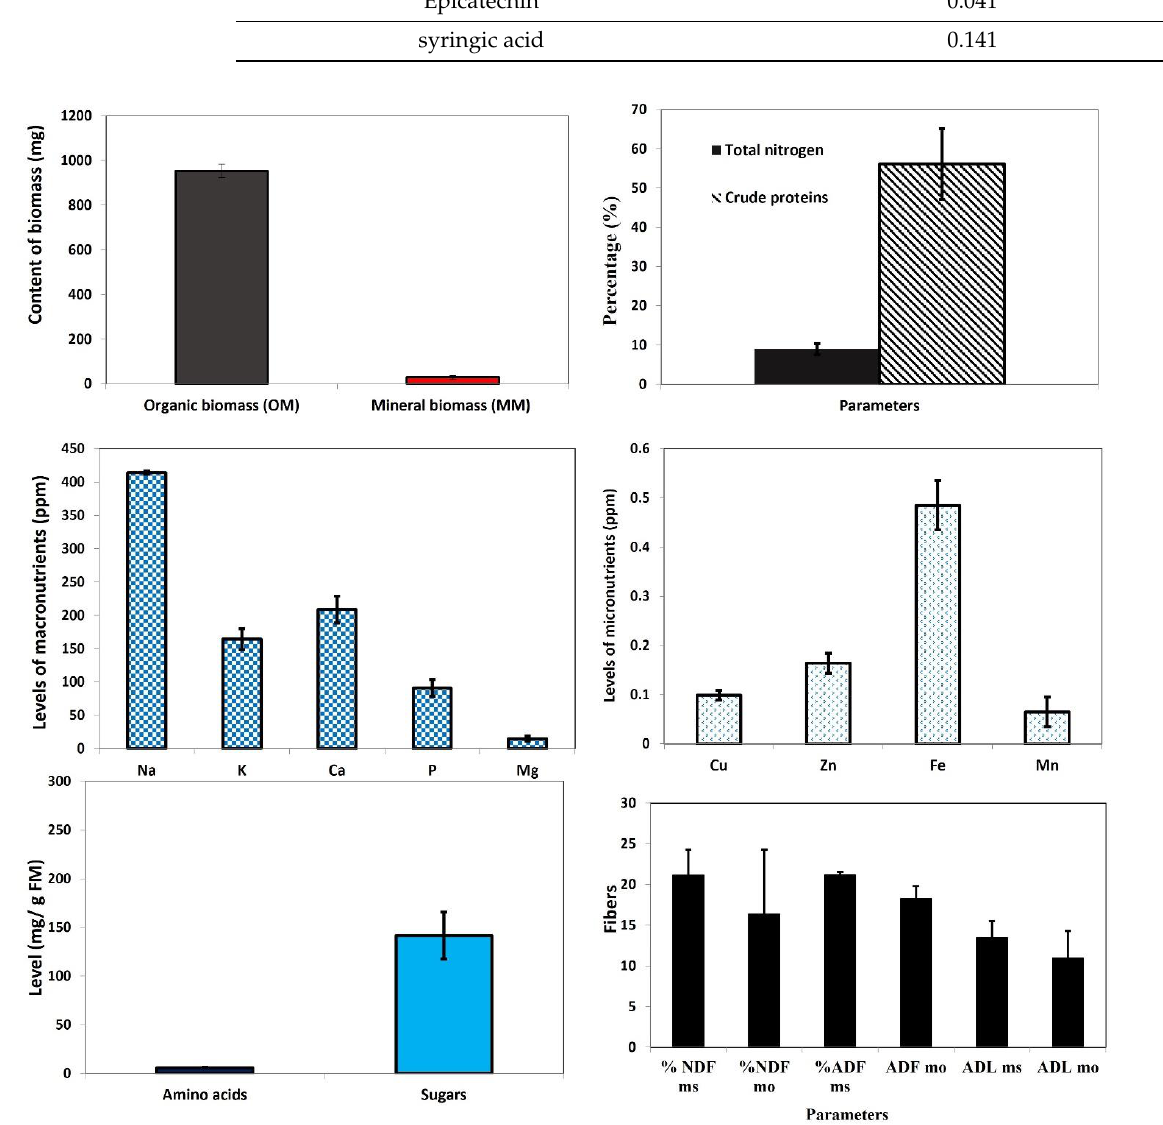
Figure 5. Contents (levels or percentages) in C. siliqua of organic biomass (OM), mineral biomass (MM), total nitrogen, crude proteins, macronutrients, micronutrients, amino acids, sugars and fibers. Acid Detergent Fiber (ADF) (cellulose and lignin); Neutral Detergent Fiber (NDF) (cellulose, hemicellulose, and lignin); Acid Detergent Lignin (ADL), Neutral detergent fiber (NDF) and acid detergent fiber (ADF). Data is means of 3 values ±SD. Significance of differences between treatments was estimated at ANOVA ( α = 5 %) highly significant ( p value < 0.001). Table 2. Identification and quantification of the phenolic compounds by HPLC-MS.